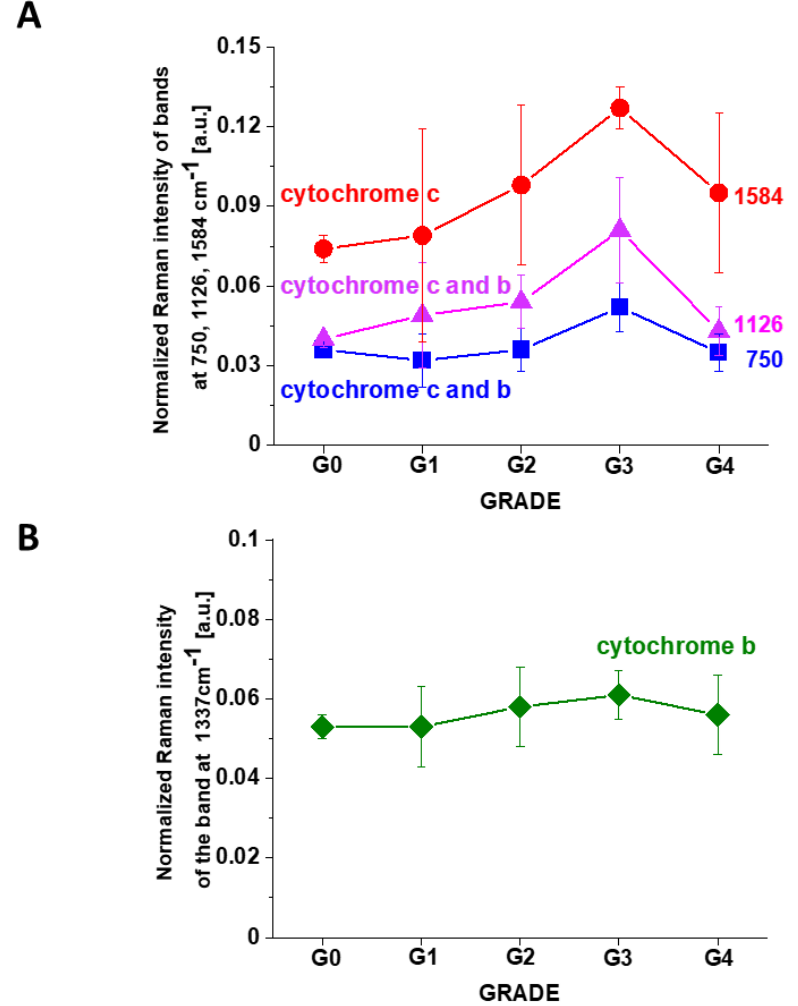
Figure 10. The Raman intensities of cytochrome c and cytochrome b in human brain tissue: I 750 , I 1126 , I 1584 ( A ) and I 1337 ( B ) as a function of brain tumor grade malignancy G0-G4 at excitation 532 nm. The results are presented as the mean ± SD. Raman bands intensity were taken from normalized by vector norm spectra.